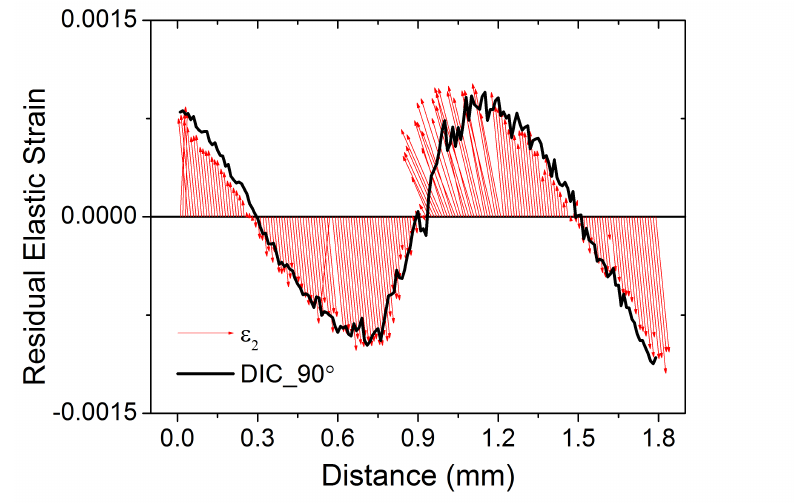
Figure 6. Quiver plot of in-plane principal strains across the central line in the bent bar plotted together with the residual elastic strain at 90 ◦ calculated using